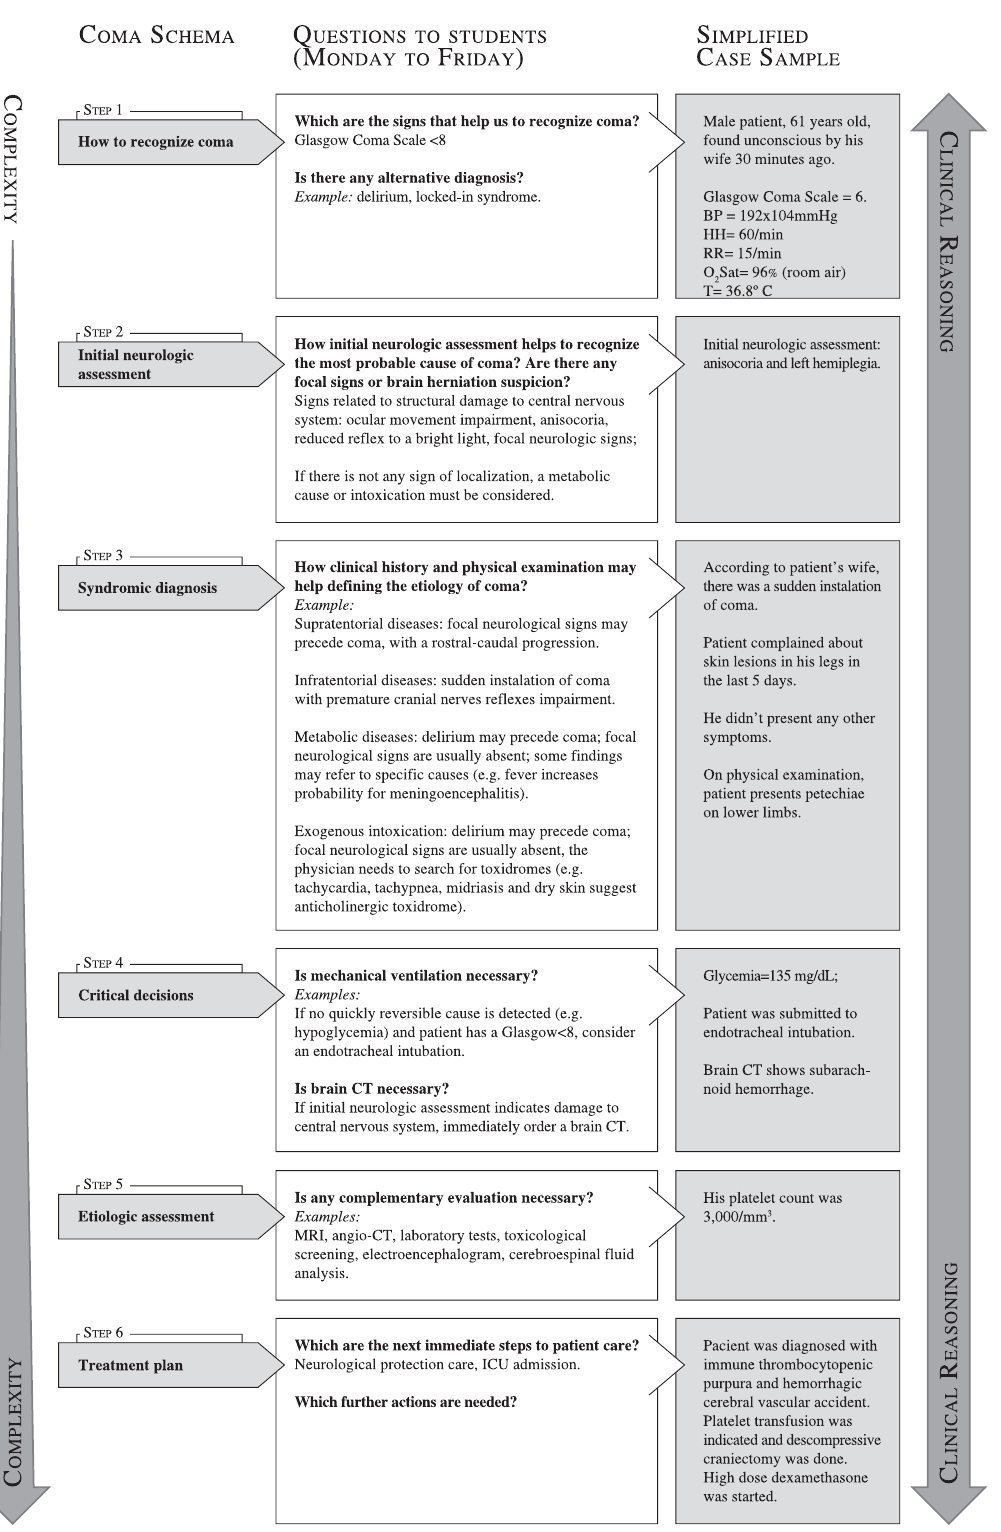
Fig 3. Virtual Rounds case construction — Coma. At left, a schema is shown in six successive steps, discussed during the week. In general, one or two steps are discussed in a single day, from Monday to Friday. The following steps were addressed only after the previous had been accessed. At right, we provide a resumed Virtual Round model, with the main information that would be discussed at the online shared forums with students, having the schema as a guide. doi:10.1371/journal.pone.0152462.g003 PLOS ONE | DOI:10.1371/journal.pone.0152462 March 31,